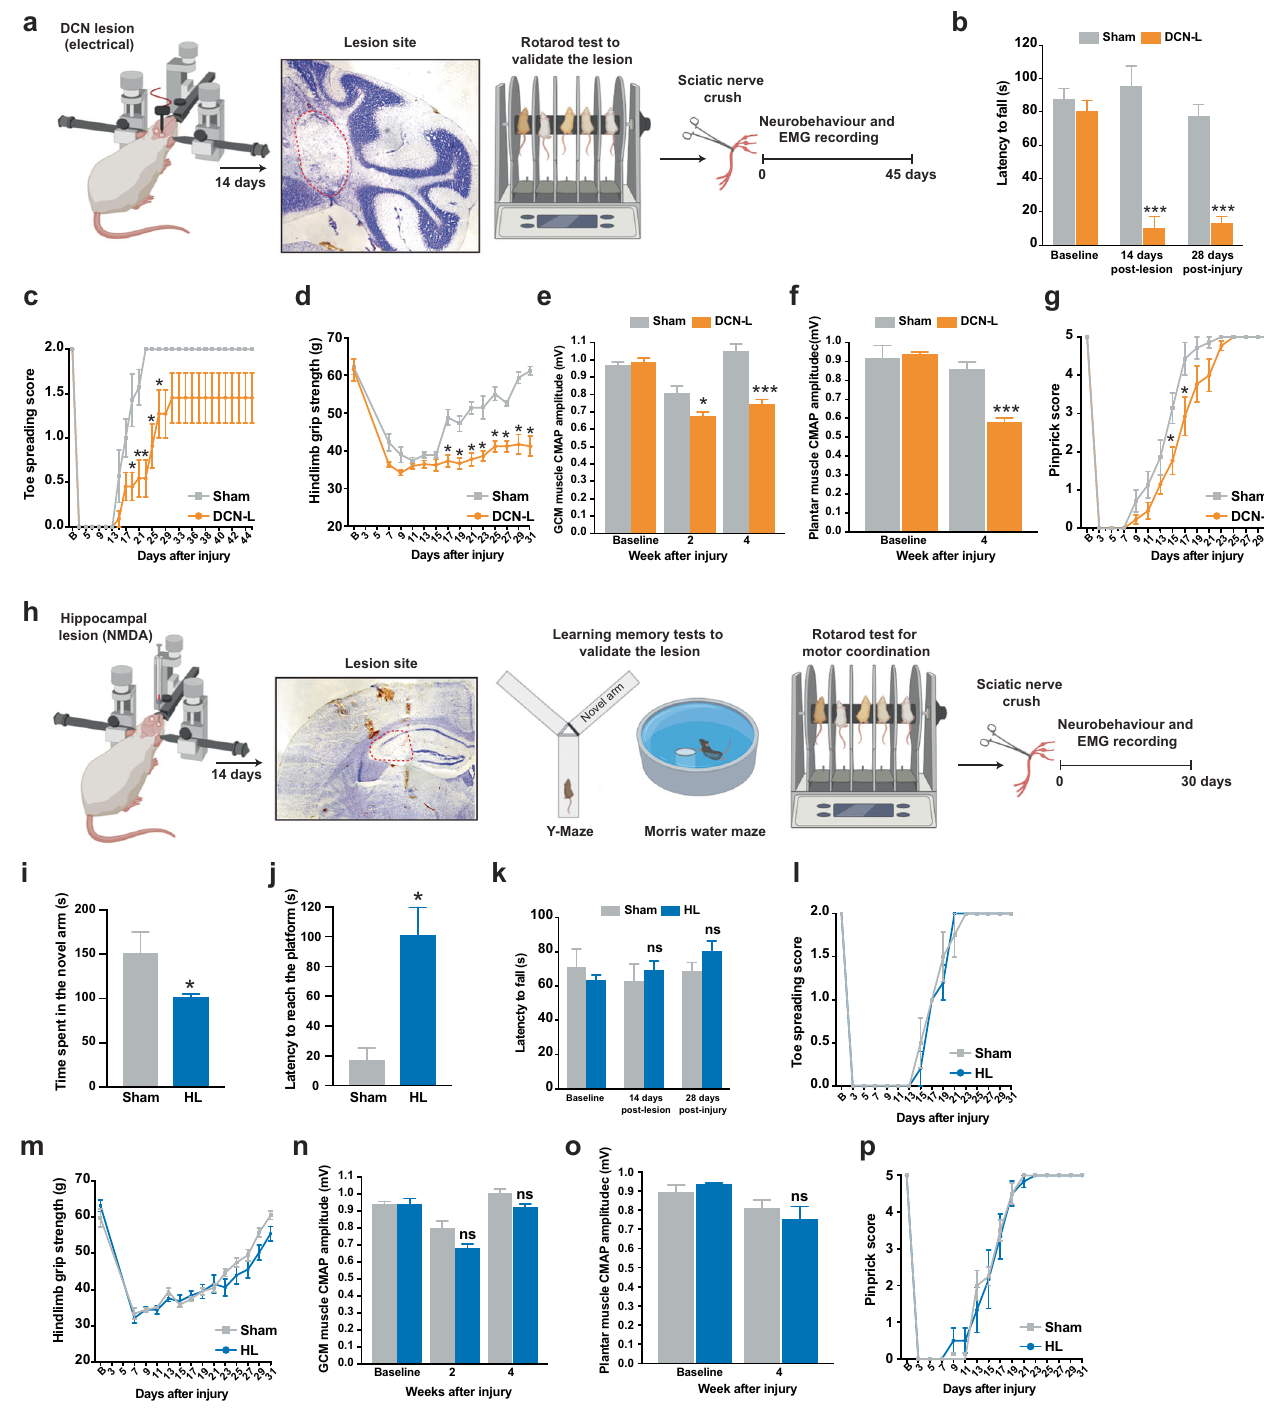
Cerebellar circuitry integrity determines motor recovery Peripheral deafferentation or limb amputation induces massive plasticity changes within cortical and sub-cortical motor areas 38 , however; there is limited understanding of how the cerebellar circuitry affects motor recovery after PNS injury. We, therefore, examine the role of DCN in motor recovery after PNI by electrical DCN lesions or to lesion a non-motor area such as hippocampus as control. Successful DCN lesion was con fi rmed by motor coordina- tion de fi cit assessed by accelerated rotarod test and histological